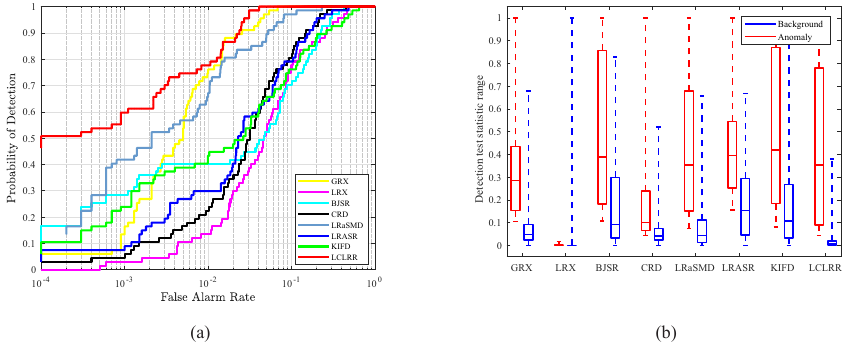
Figure 10. The ROC curves and box plots of different algorithms for the Texas Coast urban dataset. ( a ) ROC curve. ( b ) box